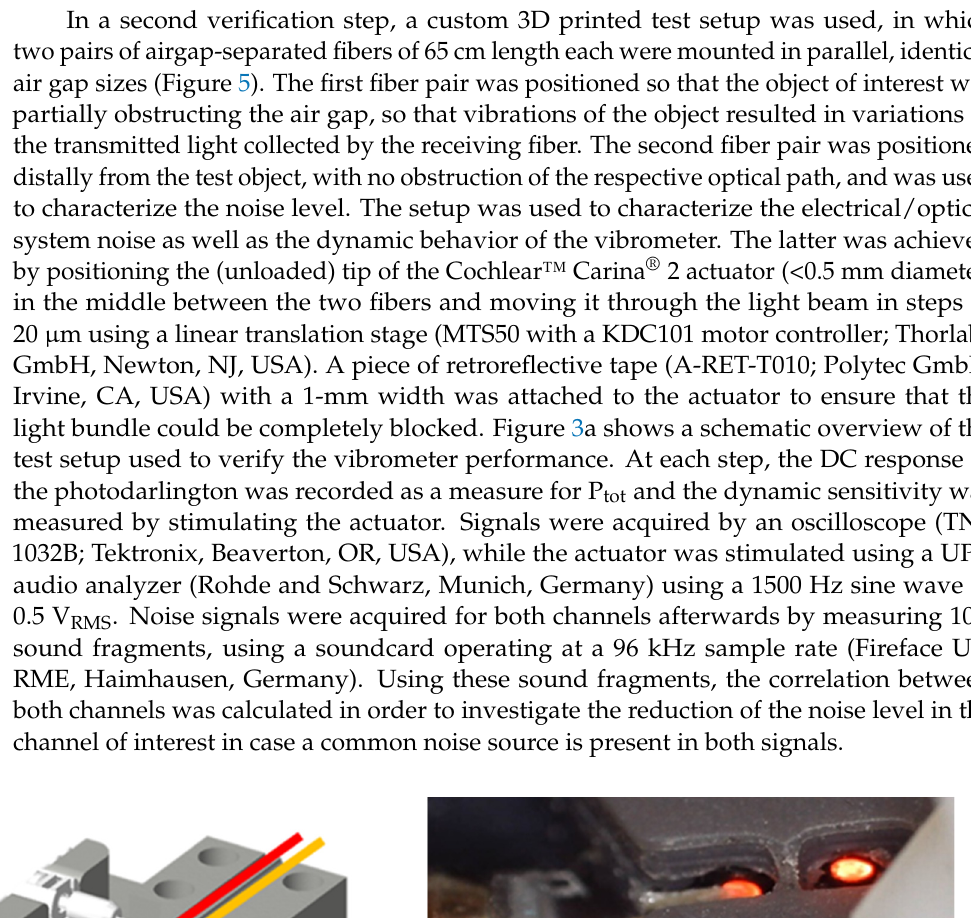
Figure 4. Schematic overview of the test setup used to quantify beam divergence.